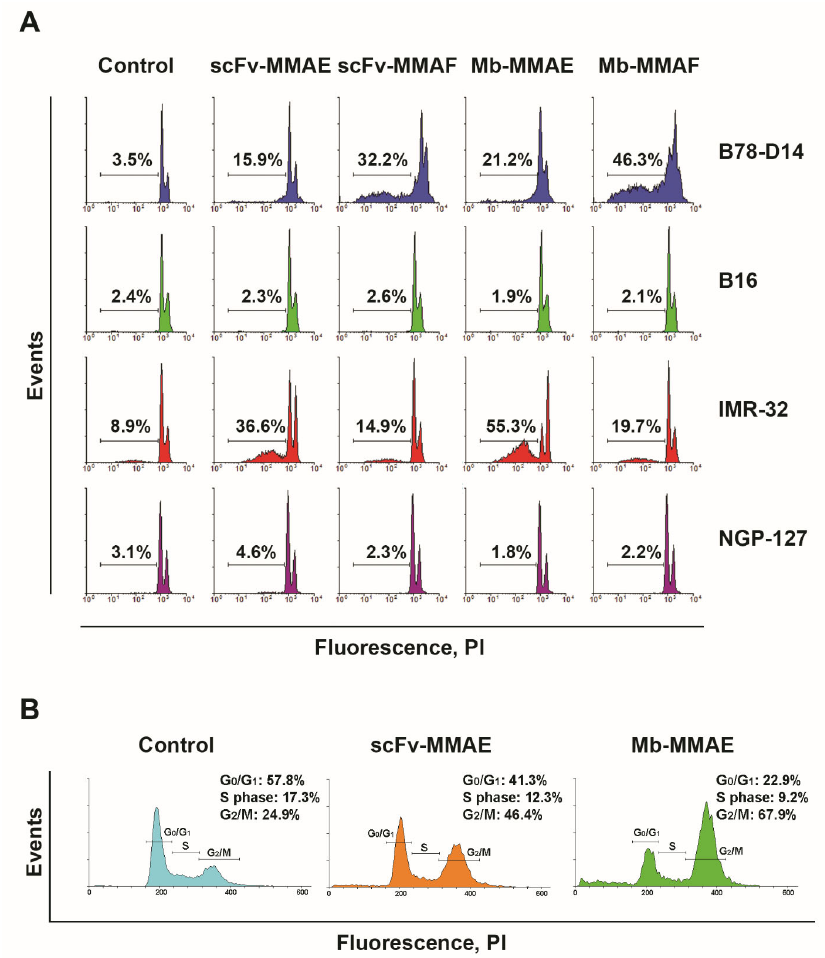
Figure 5. PI assay. ( A ) Analysis of DNA fragmentation (propidium iodide staining) of GD2 ‐ positive (B78 ‐ D14 and IMR ‐ 32) and GD2 ‐ negative (B16 and NGP ‐ 127) cell lines treated with FDCs (100 nM) for 48 h. Control—untreated control cells. The percentage of cells with fragmented DNA in hypodiploid peaks is shown for each histogram. ( B ) Cell cycle analysis (propidium iodide staining) of GD2 ‐ positive human neuroblastoma IMR ‐ 32 treated with FDC ‐ MMAE (100 nM) for 48 h. Control—untreated control cells. scFv–scFv fragments 14.18, Mb–minibodies 14.18.